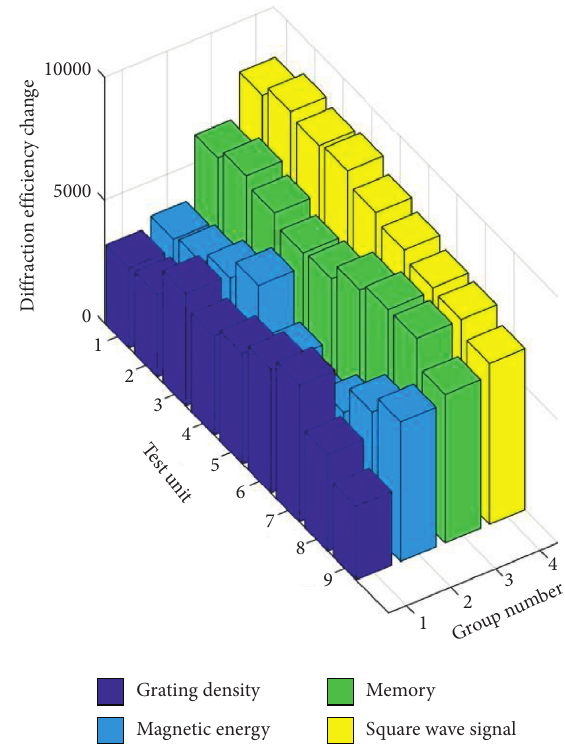
Figure 4: Rate of change of diffraction efficiency of